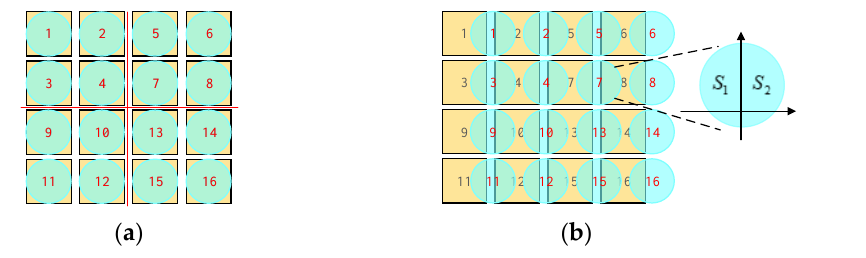
Figure 3. Image spot distribution diagram at the receiver. ( a ) Transceiver alignment. ( b ) Transceiver misalignment.